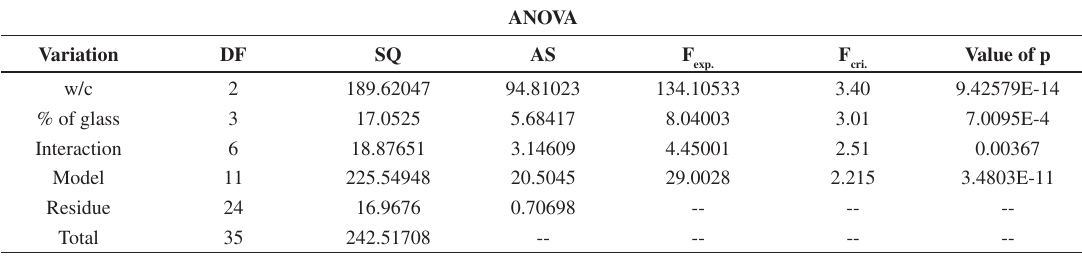
Table 4. ANOVA values of the compressive strength test to determine the effects of the w/c ratio and waste glass percentage after 14 days of curing.